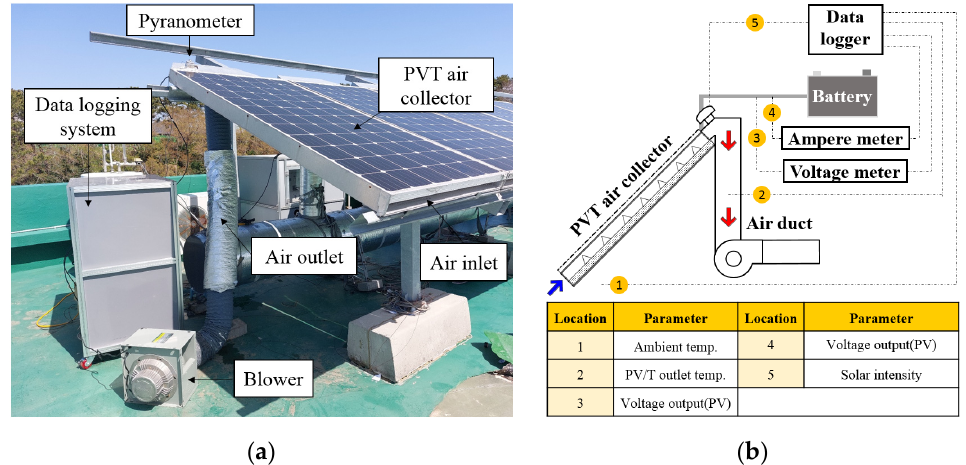
Figure 4. Actual view and schematic of the experimental setup: ( a ) Actual view; ( b ) Schematic of the experimental setup with measuring points.